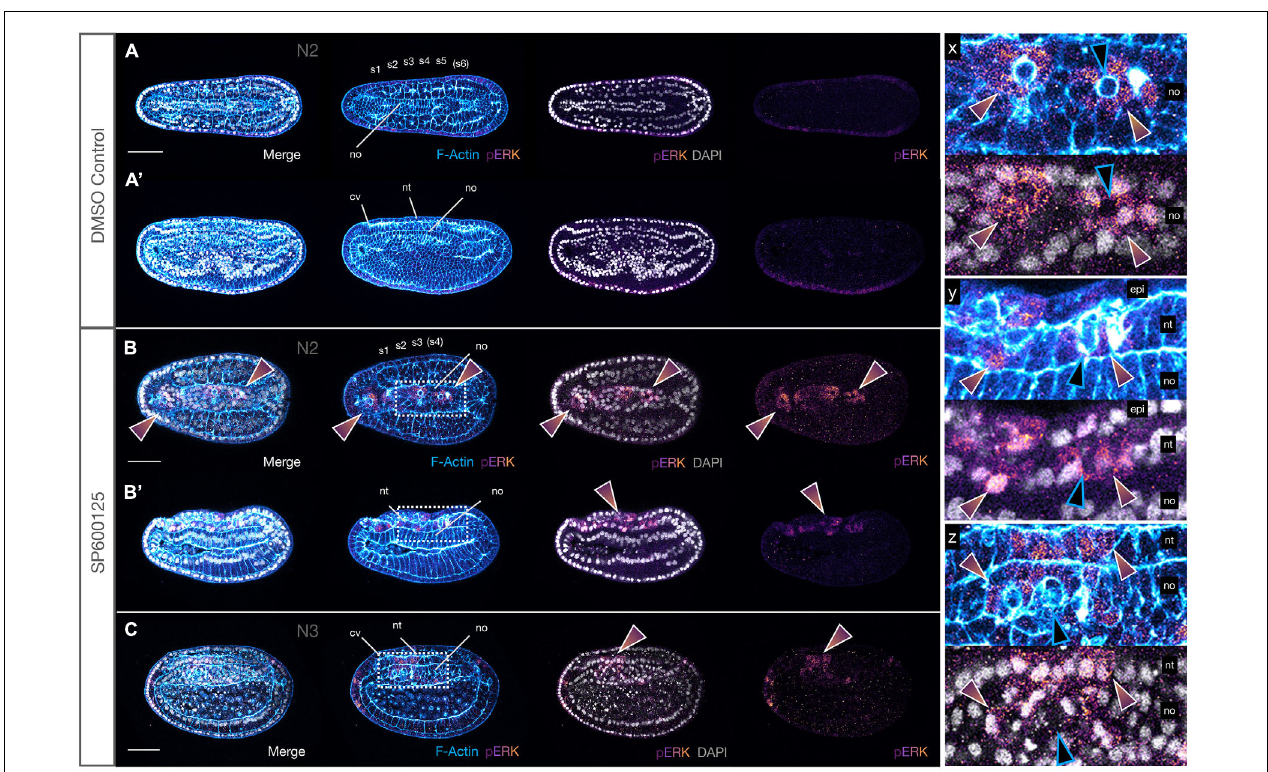
FIGURE 10 | JNK inhibition leads to upregulation of pERK in neighbours of extruding cells. (A,A (cid:48) ) N2 stage DMSO control embryo with five formed somite pairs. The notochord cells are arranged in two parallel rows, except anteriorly under the cerebral vesicle, and are multiple cell layers thick. There is little to no pERK staining. (B,B (cid:48) ) SP600125-treated embryos allowed to progress to the same stage have broader monolayered notochords. They accumulate cytoplasmic and nuclear pERK in notochord (rainbow arrowheads in B,B (cid:48) and inset y) and overlying neural and epidermal cells (rainbow arrowheads in B and inset x). Two different embryos are shown. (C) This pattern is seen in treated embryos allowed to progress to the equivalent of the N3 stage, in which notochord cells appear to attempt to stack dorsoventrally in multiple layers (inset z). In all cases, pERK accumulation occurs in cells neighbouring rounding cells apparently in the process of extruding (note apical rounding and F-Actin accumulation in membranes, blue outlined black arrowheads in insets x, y, and z). Phalloidin staining of F-Actin is in blue and phosphorylated ERK (pERK) immunoreactivity is in a purple/orange gradient, while DAPI stained nuclei are in grey. Embryos are orientated with anterior to the left either dorsal ( A,B and inset x) or lateral views ( A (cid:48) ,B (cid:48) ,C and insets y and z) are shown. Representative embryos are shown. cv, cerebral vesicle; epi, epidermis; nt, neural tube; no, notochord; pharynx, ph; pp, preoral pit; s1, s2, etc., somite pairs. Scale bars = 50 µ